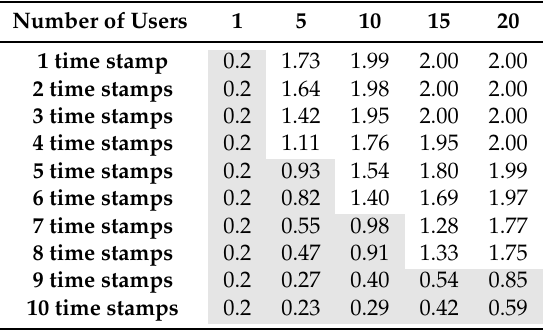
Table 2. Average distance error (meters) for different numbers of users and time